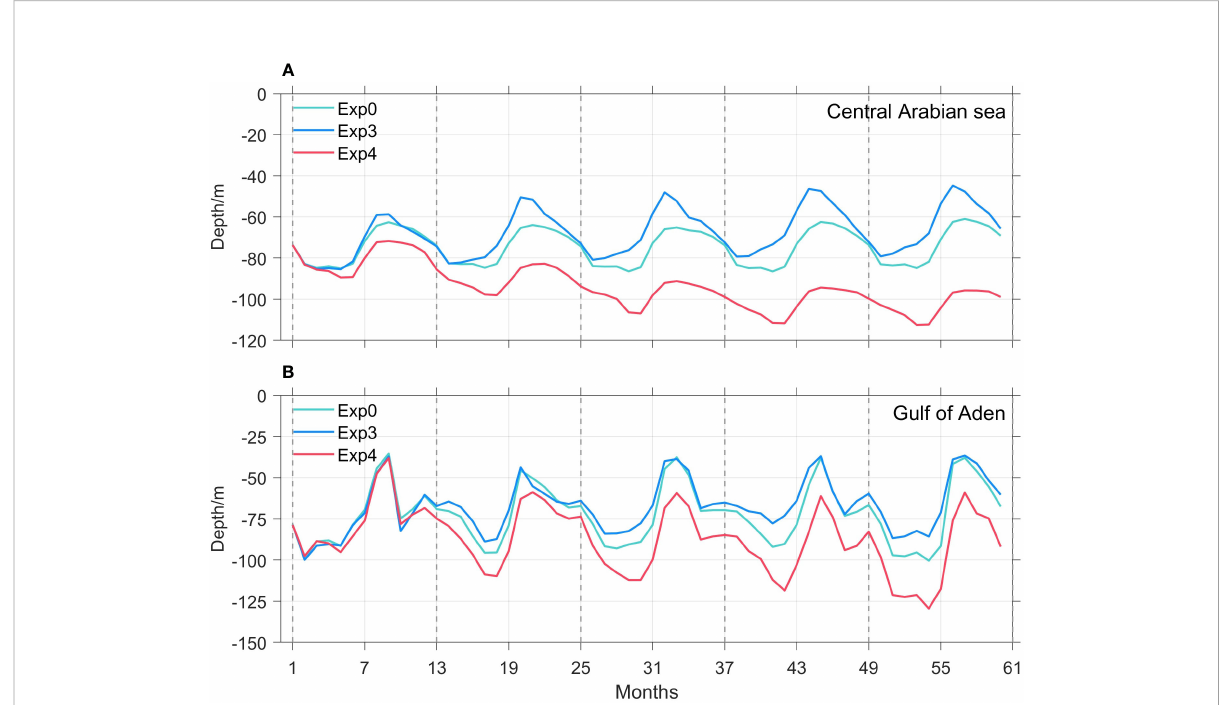
FIGURE 11 Time series of the upper boundary of the ASOMZ at site A ( A ; central Arabian Sea) and site B ( B ; Gulf of Aden) from three experiments (Exp0, Exp3, and Exp4).